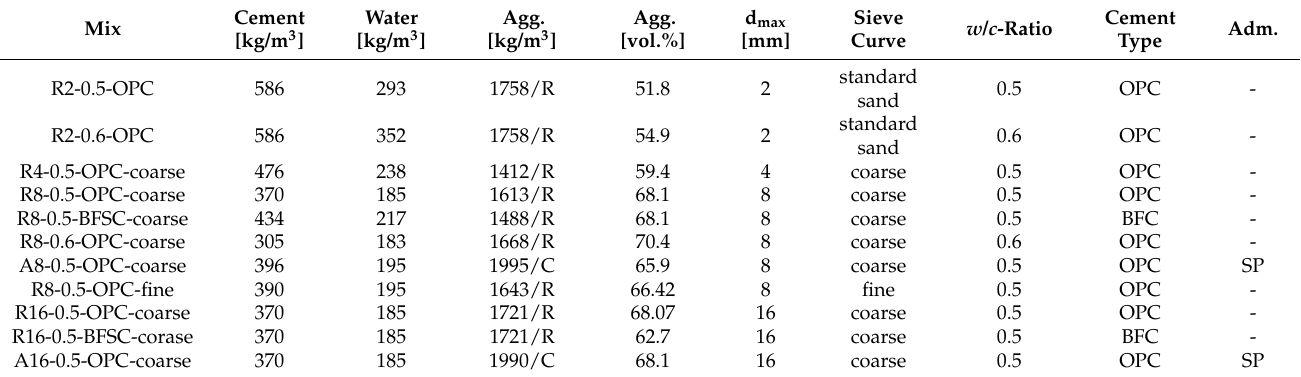
Table 1. Investigated concrete mixtures with overview of varied mixture components (abbreviations: R = round aggregates, A = angular aggregates, d max = maximum aggregate size, Agg. = Aggregate, w / c = water-to-cement ratio, OPC = Ordinary Portland Cement, BFSC = Blast Furnace Slag Cement, Adm. = Admixture, SP = Superplasticizer).